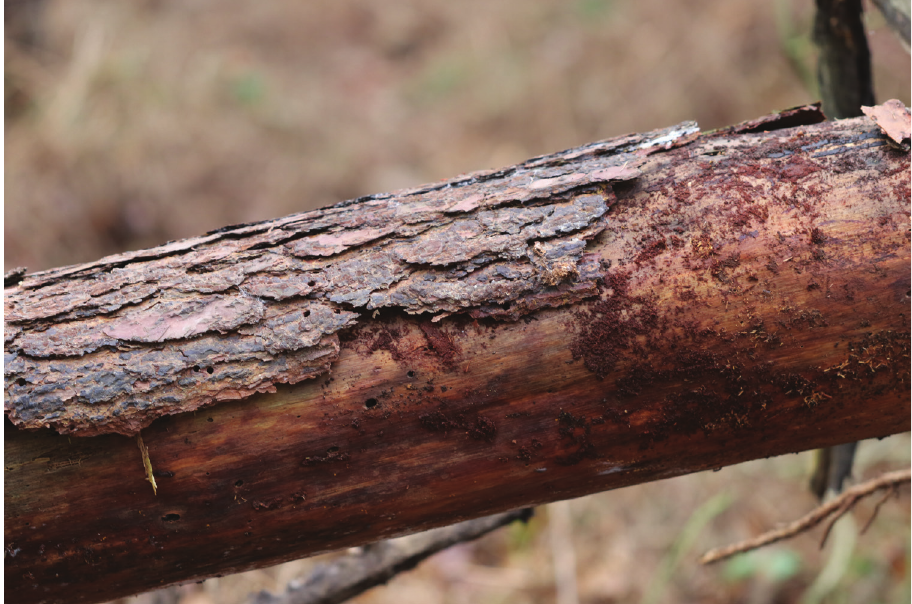
Figures 6. Example in Belgium of trees used by several ichneumonid wasps to hibernate beneath the bark; Quercus robur L., Zillebeke (Hogebos), 14 February 2020 and Pinus sylvestris L., Zillebeke (Papenelst), 23 December 2019. Fons